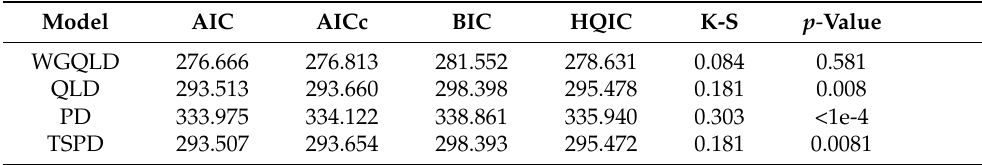
Table 9. The measures AIC, AICc, BIC, HQIC, and K-S with the corresponding p -value for aircraft windshield